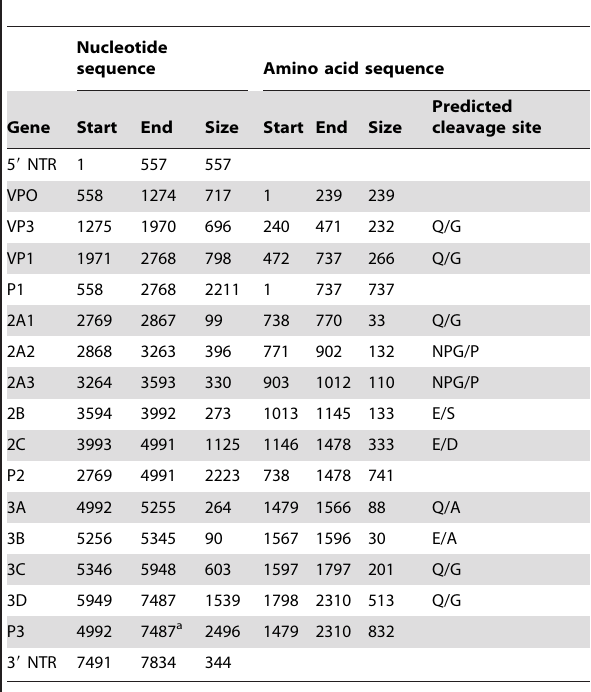
Table 3. Prediction of different polyproteins in FHMPV